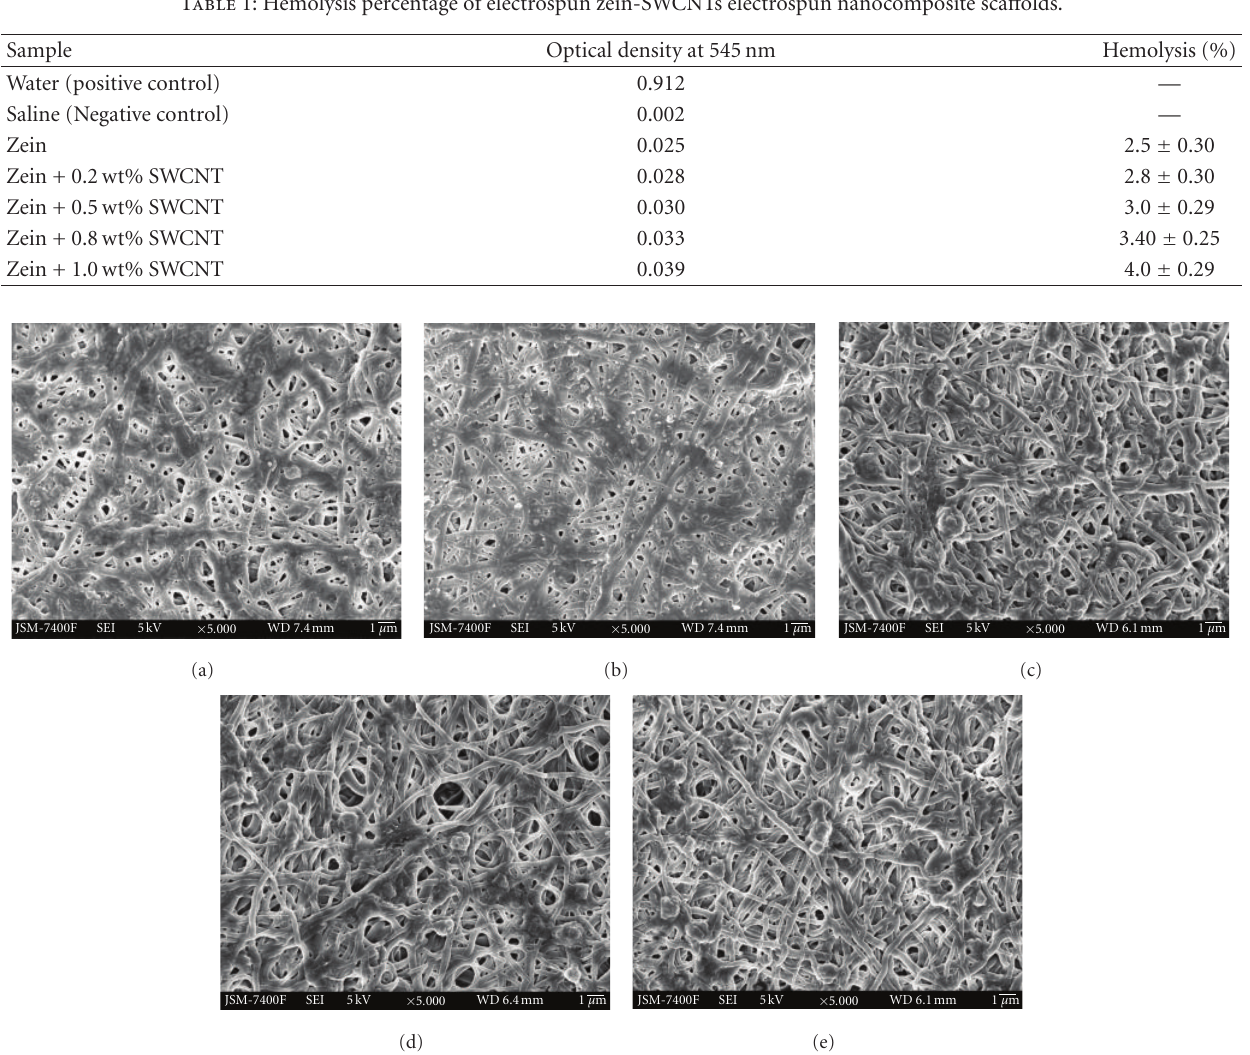
Figure 6: E ff ects of the composite nanofibers on the adhesion of blood platelets. (a) Zein nanofiber, (b) Zein-0.2wt% SWCNTs, (c) Zein- 0.5wt% SWCNTs, (d) Zein-0.8wt% SWCNTs, and (e) Zein-1wt% SWCNTs nanocomposite Sca ff olds (scale Bar: 1 μ